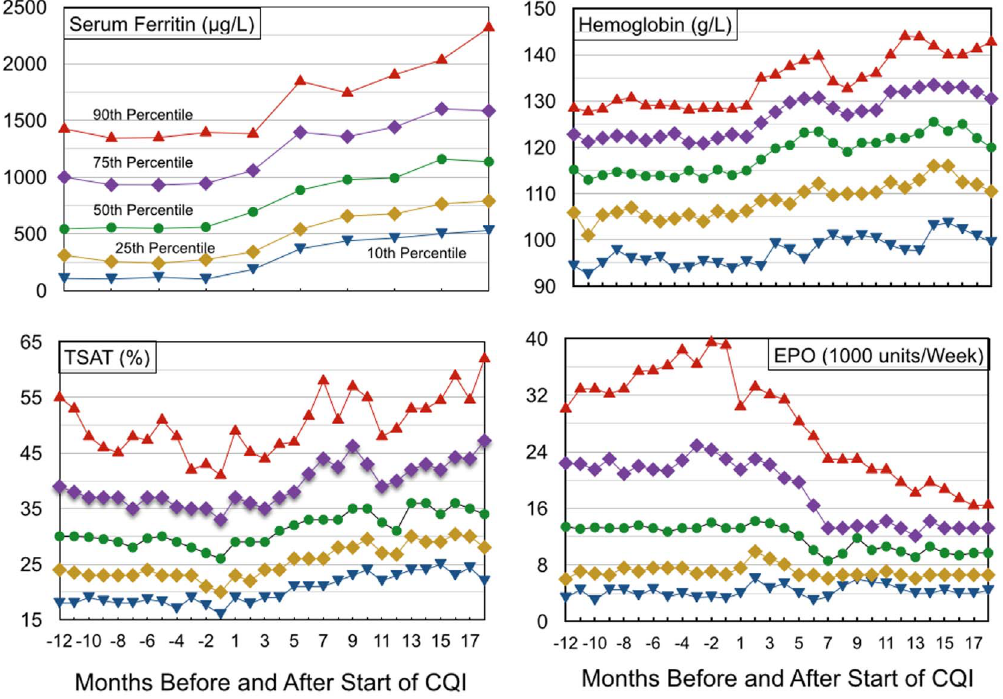
Figure 5. Percentiles of patients by (a) serum ferritin, (b) TSAT, (c) hemoglobin, and (d) administered EPO for 12 months before and 18 months after study start.